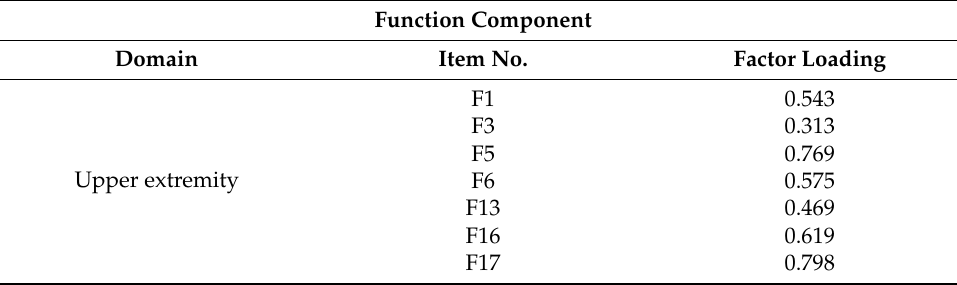
Table 5. Factor analysis for the Function component of the K-LLFDI with three